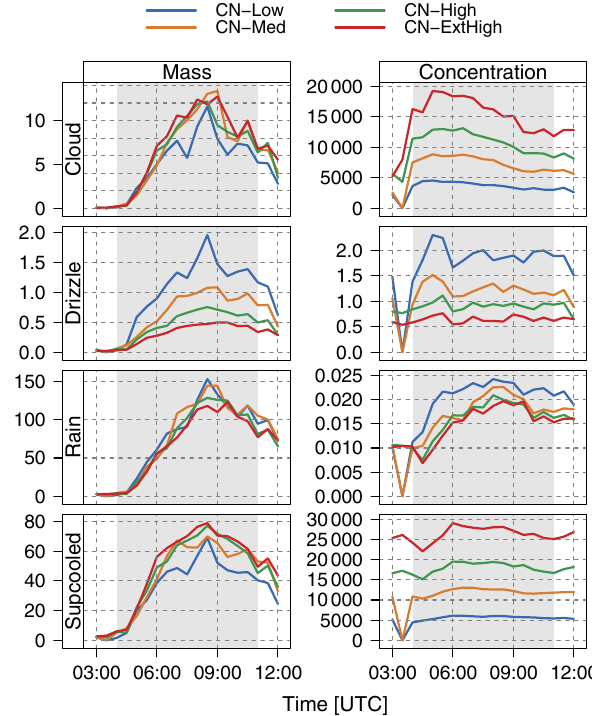
Figure 11. Volume integrals of cloud, drizzle, rain and supercooled cloud in terms of mass (1 × 10 8 kg) and number concentration (1 × 10 5 m − 3 ) throughout time for the CN-Low (blue), CN-Med (marigold), CN-High (green) and CN-ExtHigh (red) experiments. Only grid columns with updrafts greater than 5ms − 1 are consid- ered in the computation. The number concentrations are weighted by their respective mass. The shaded area in grey represents the time period that the entire MCS is within the grid